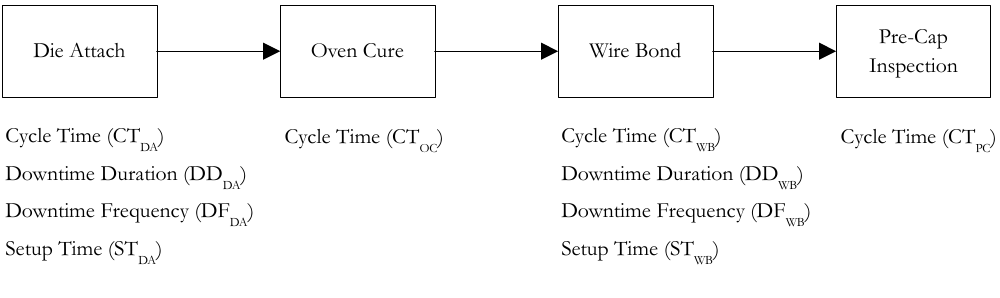
Figure 2. The process parameters for a semiconductor assembly line